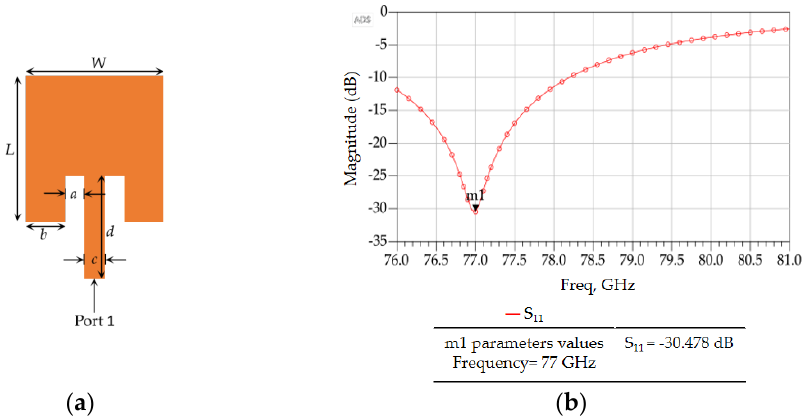
Figure 17. ADS generated 3D FEM simulation results for the 8 × 8 Butler matrix. ( a ) Return loss and